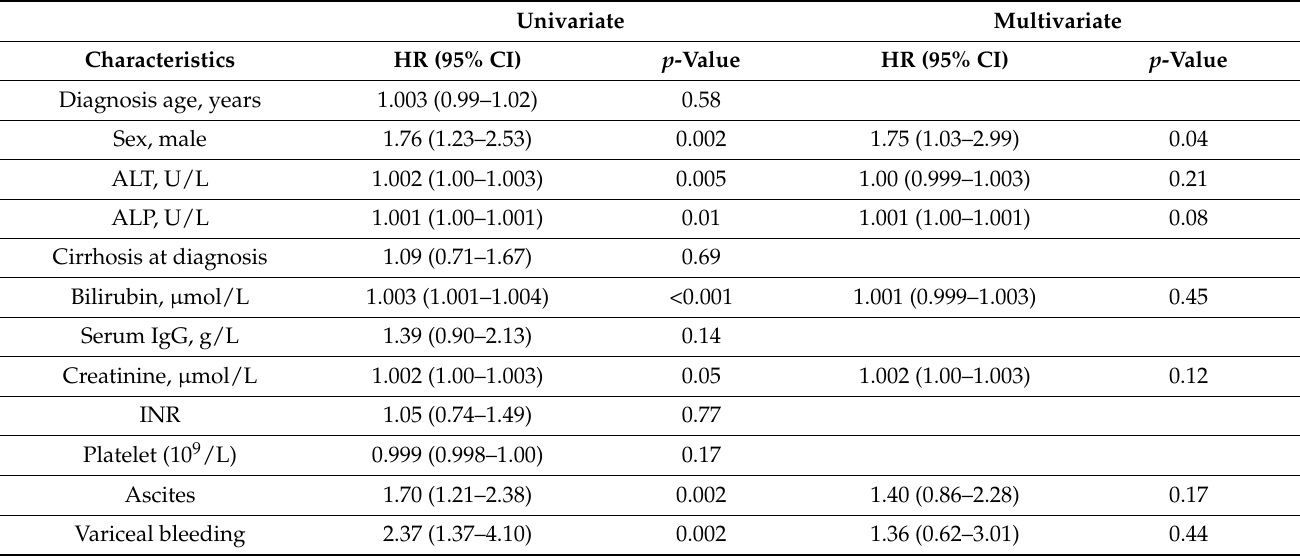
Table 3. Parameters Associated with Liver-Related Events (Mortality and Transplantation) in